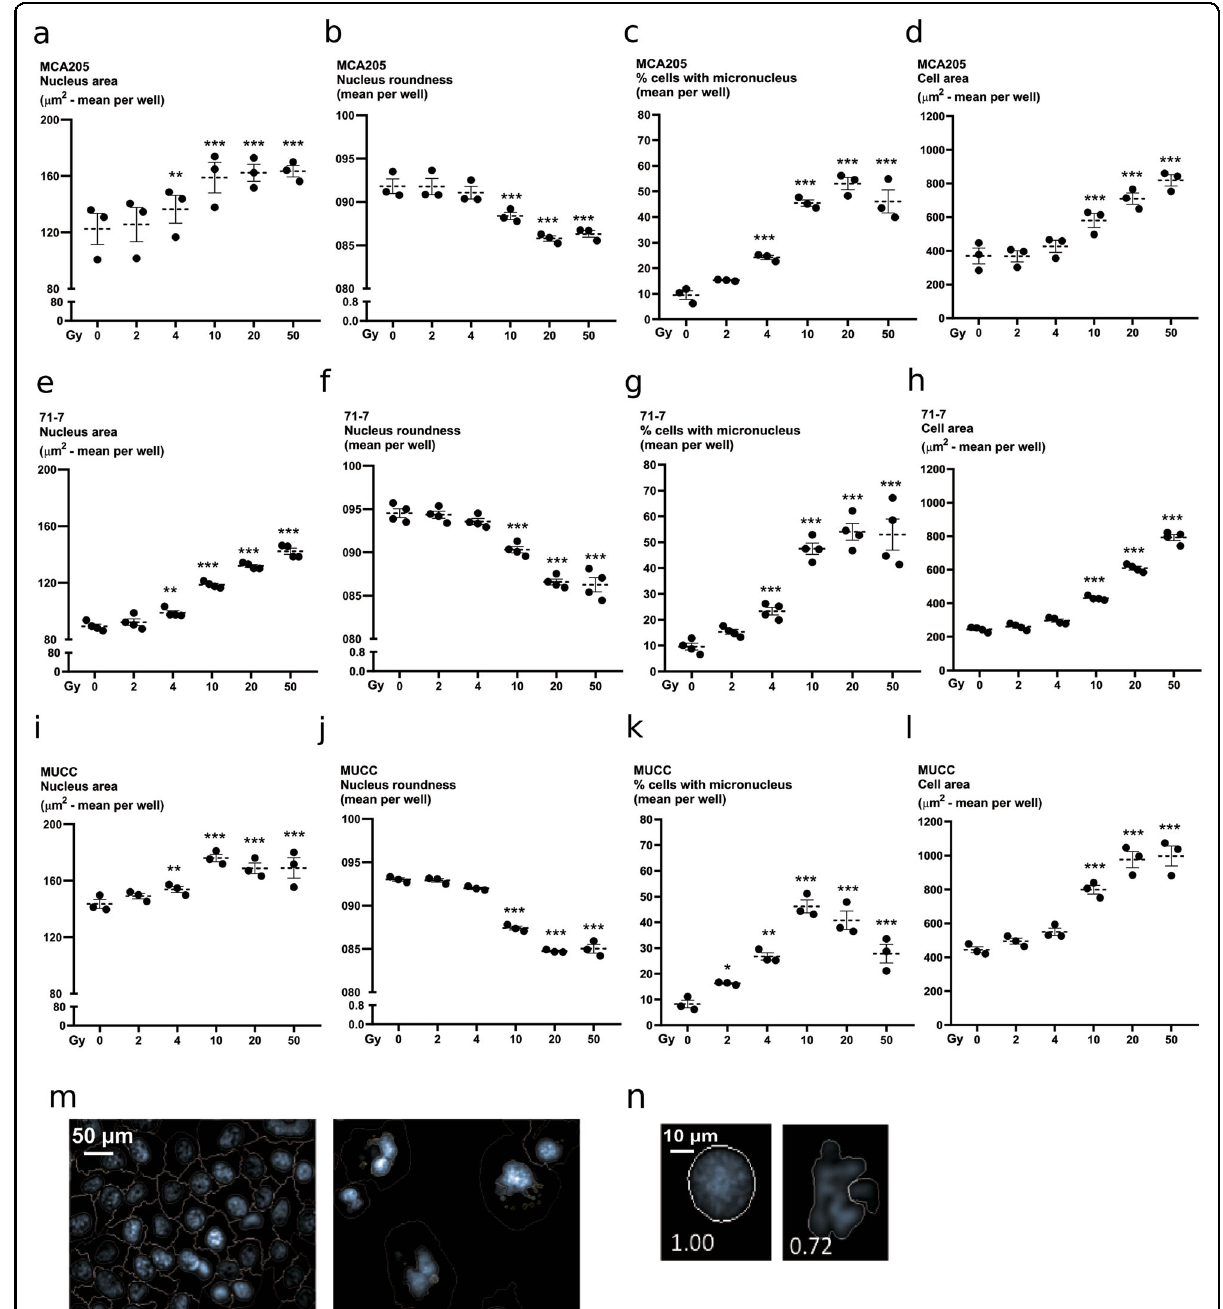
Fig. 4 Induction of multinucleation and micronucleation by ionizing radiation. Nuclear morphology was quanti fi ed through high-content imaging in MCA205 ( a – d ), 71-7 ( e – h ), MUCC ( i – l ) cells, 48 h after irradiation. Cells were stained with Hoechst and propidium iodide after permeabilization to allow segmentation of the nucleus and cytoplasm, respectively. Nuclear area was measured in MCA205 ( a ), 71-7 ( e ), and MUCC ( i ). The roundness of the nucleus was also assessed after irradiation in MCA205 ( b ), 71-7 ( f ), and MUCC ( j ). Percentage of cells with micronuclei is shown for MCA205 ( c ), 71-7 ( g ), and MUCC ( k ) cells. The area of the cells was also measured following irradiation in MCA205 ( d ), 71-7 ( h ), and MUCC ( l ) cells. m Representative picture of micronuclei segmentation. n Representative picture of segmentation mask for the assessment of the nuclear